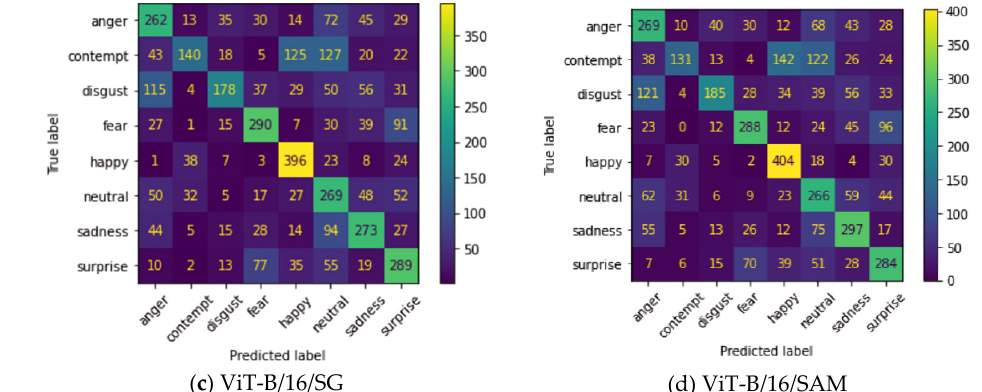
Figure 13. Confusion matrix on AVFER testing.